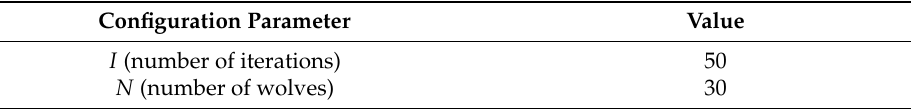
Table 6. BGWO Configuration Parameters.